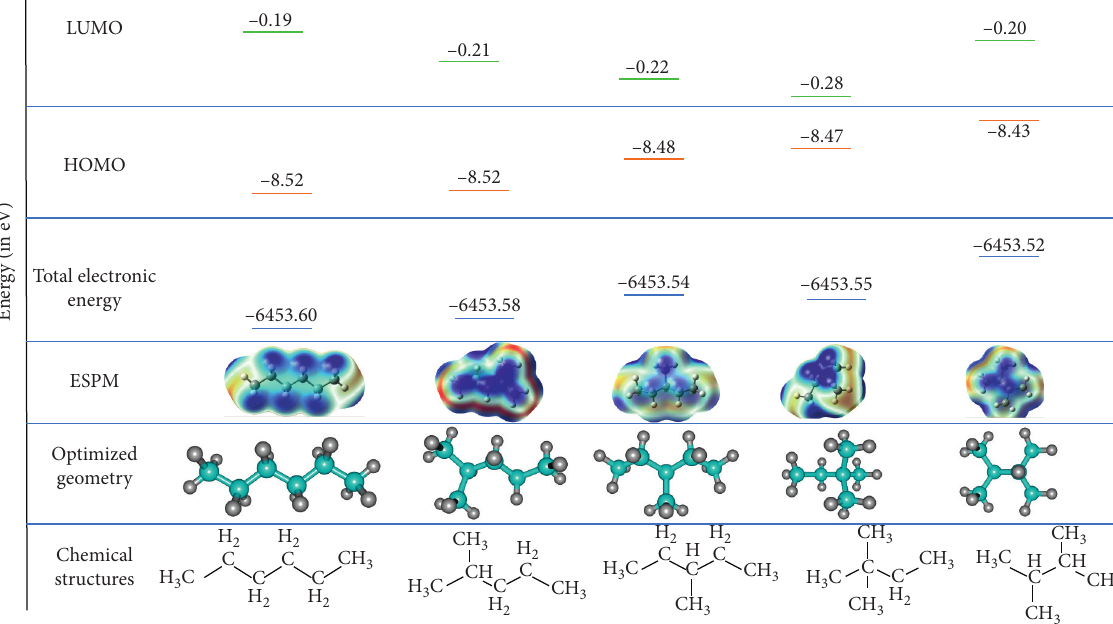
Figure 3: The chemical structures, optimized geometries, the distributions, and energies of the highest occupied molecular orbitals (HOMOs) and the lowest unoccupied molecular orbitals (LUMOs) and also the total densities mapped with electrostatic potentials (ESPMs) at isovalue � 0.2 a.u. of (a) hexane, (b) 2-methylpentane, (c) 3-methylpentane, (d) 2,2-dimethylbutane, and (e) 2,3-dimethylbutane.